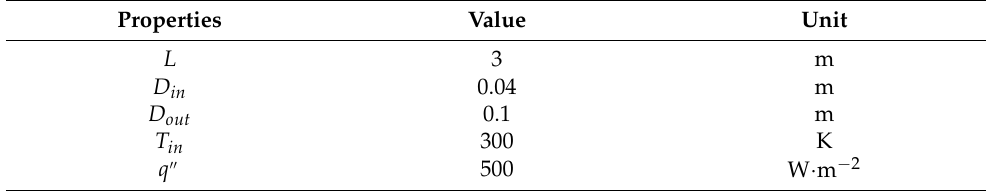
Table 1. Geometrical dimensions and operating parameters of the problem.